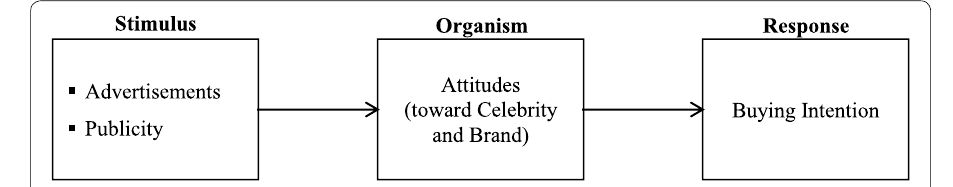
Fig. 1 Application of S‑O‑R model for the current